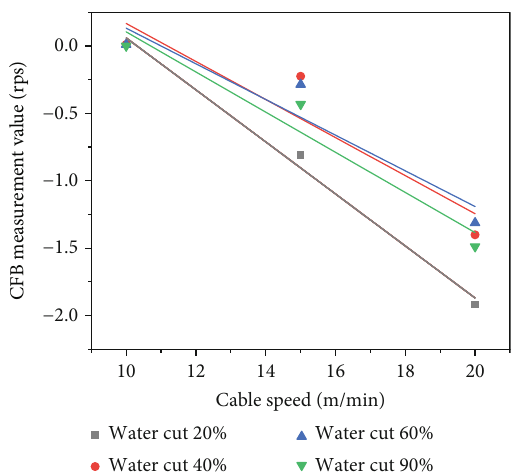
Figure 12: Relational graph of the measured value of 90 ° inclination of 600m 3 /d CFB and cable speed.